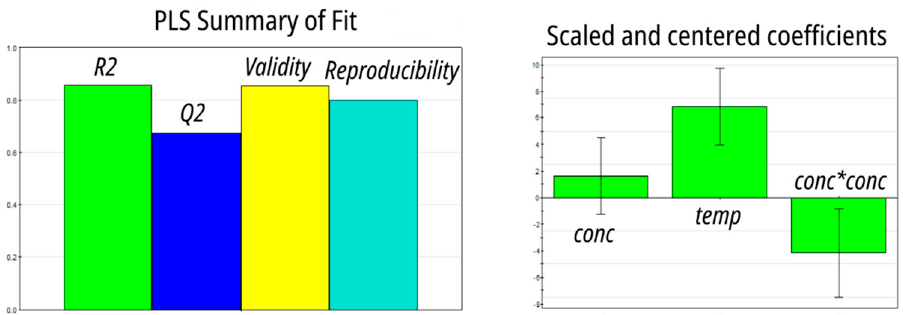
Figure 4. Optimization of LLE in batch using extractant 8 : a PLS model based on a central composite face-centered design.